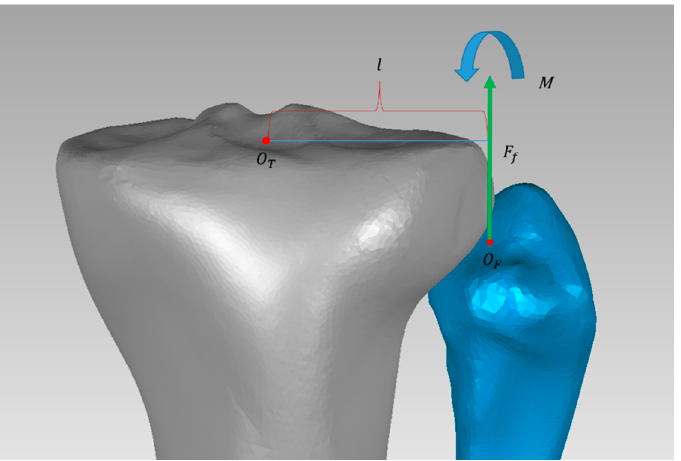
Figure 3. Illustration of fibula function to the tibia.